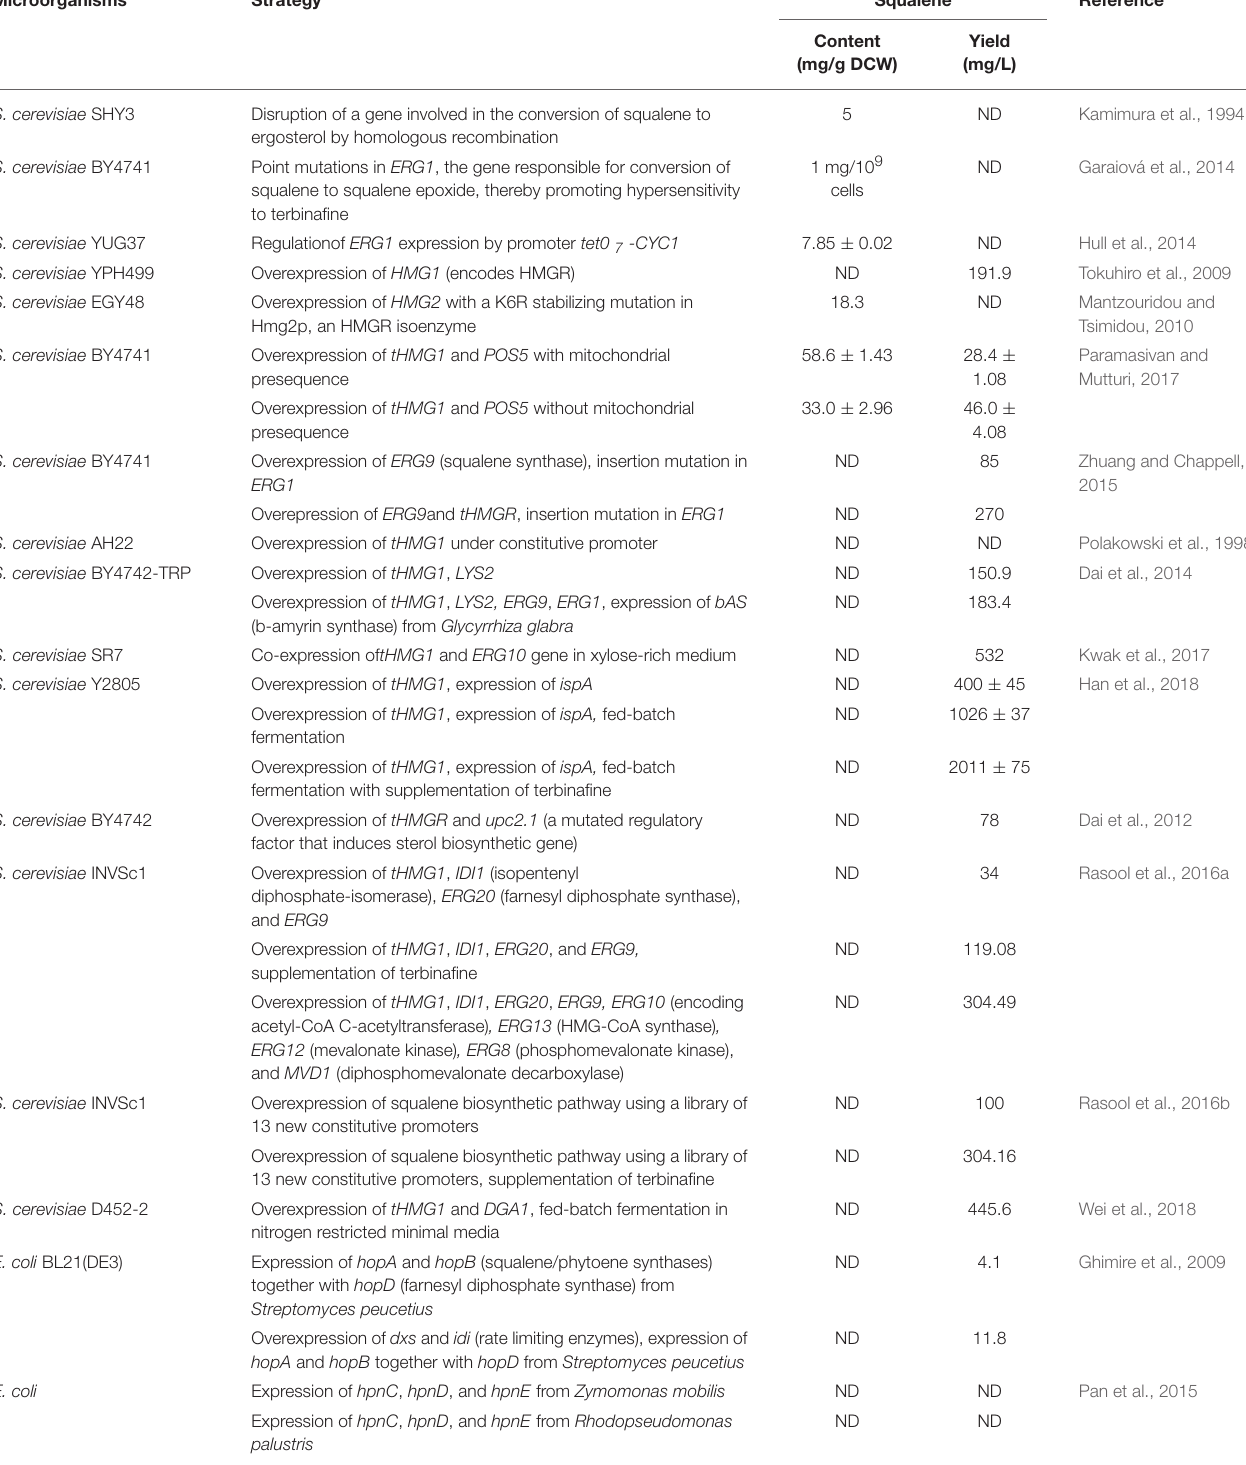
TABLE 4 | Squalene production in engineered microorganisms.